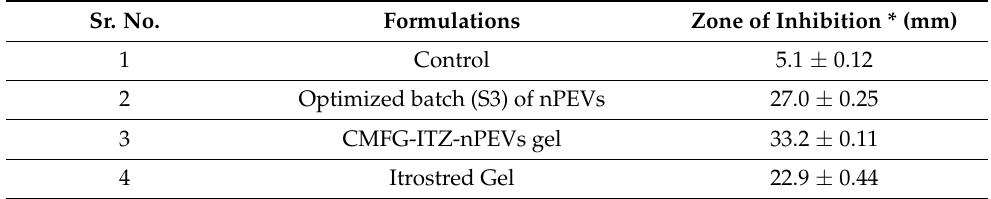
Table 5. Antifungal activity of various formulation.